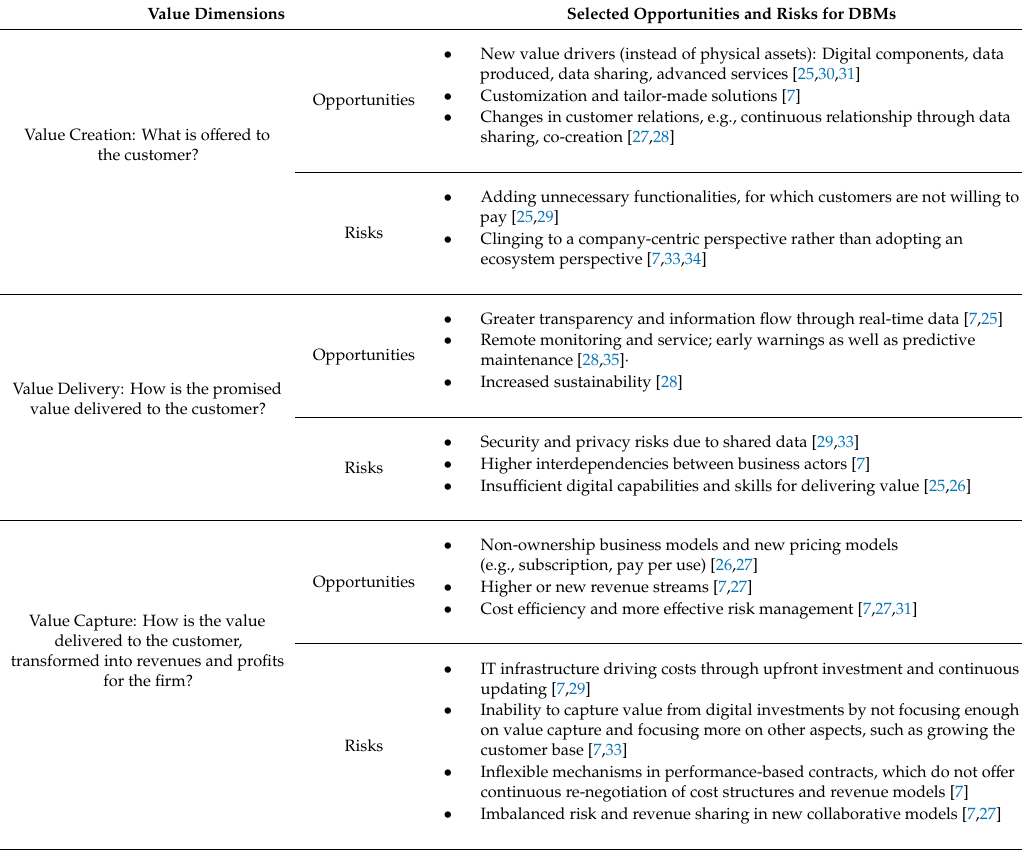
Table 4. Opportunities and risks in each value dimension for digital business